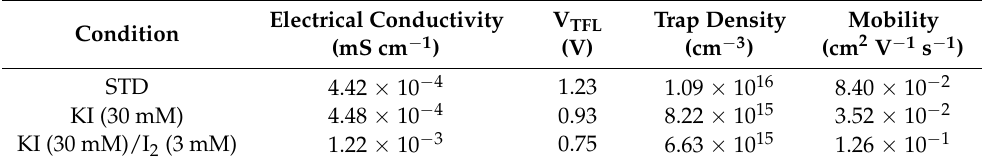
Table 5. The SCLC data of PSCs with various optimal conditions (STD, KI, and KI/I 2 ).